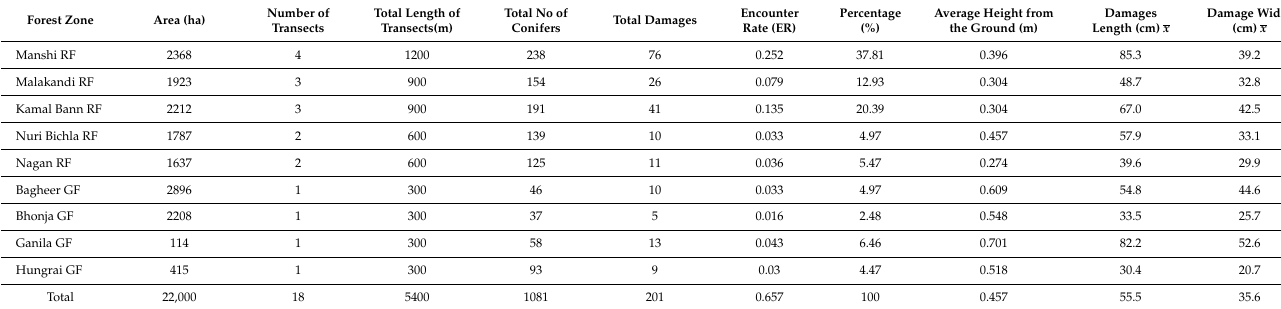
Age of Claw Marks on